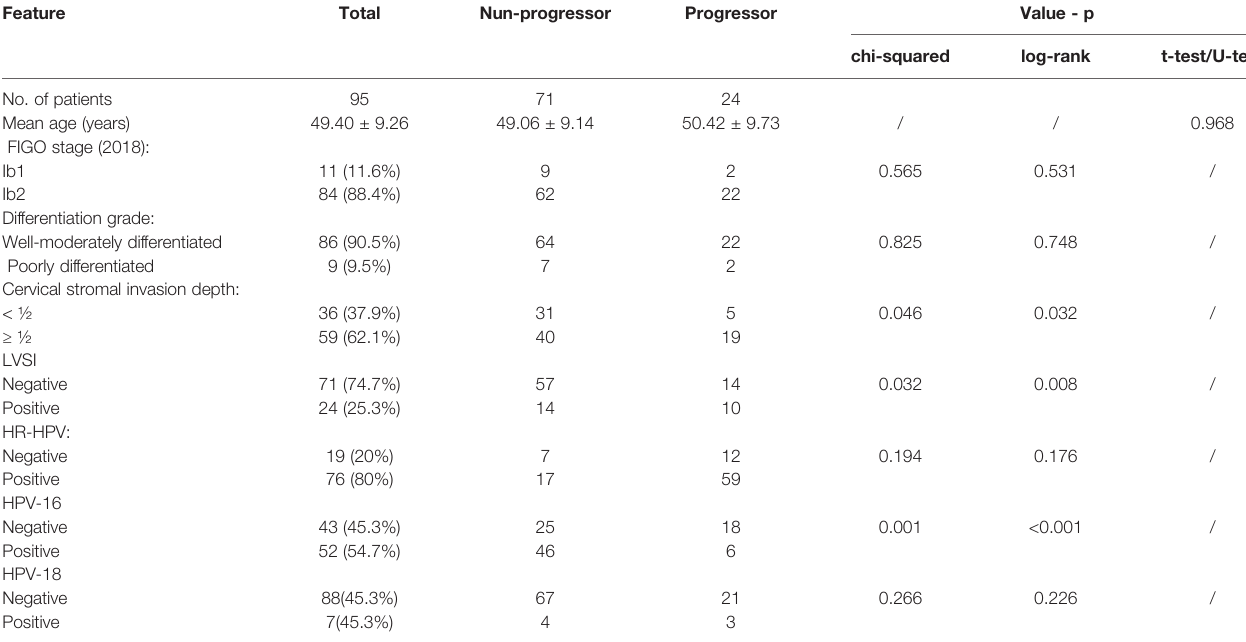
FIGO stage (2018): Postoperative pathological staging; LVSI, lymphovascular space invasion; HR-HPV, high-risk human papillomavirus; Normal distribution data, means ± standard deviations; t-test. Non-normal distribution data, medians and interquartile ranges; U-test. /, No